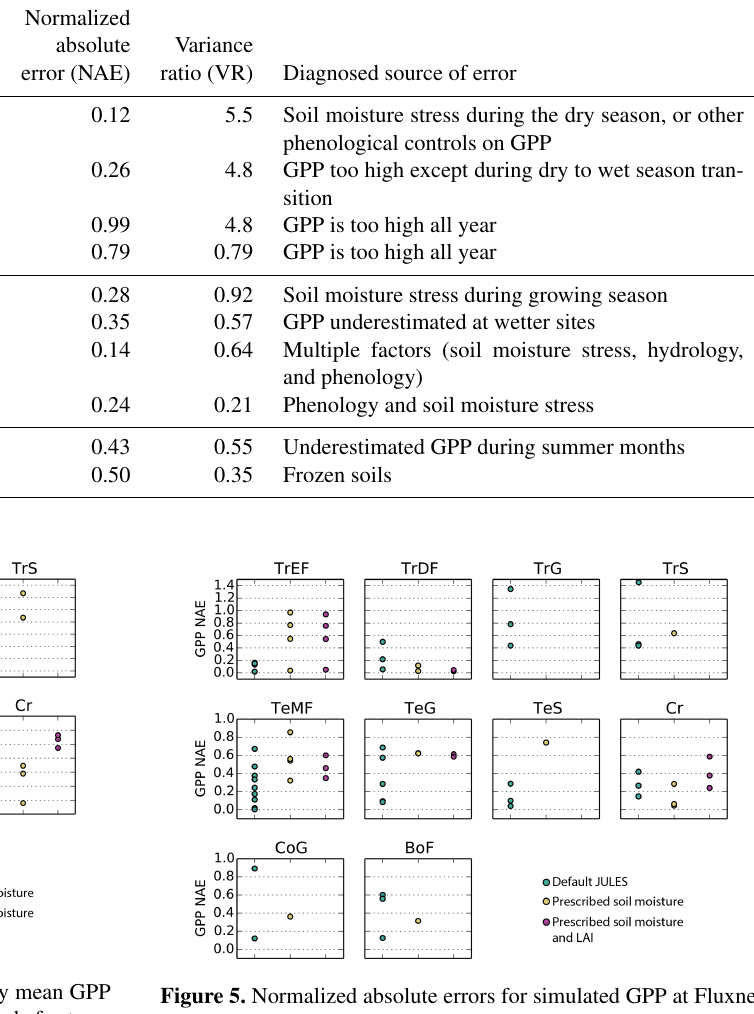
Figure 5. Normalized absolute errors for simulated GPP at Fluxnet sites for the following 10 biomes: TrEF stands for tropical evergreen forests, TrDF stands for tropical deciduous forests, TrG stands for tropical grasslands, TrS stands for tropical savannas, TeMF stands for temperate mixed forests, TeG stands for temperate grasslands, TeS stands for temperate savannas, Cr stands for cropland, CoG stands for continental or high-altitude grasslands, and BoF stands for boreal forests. The sites that fall into each category are listed in the